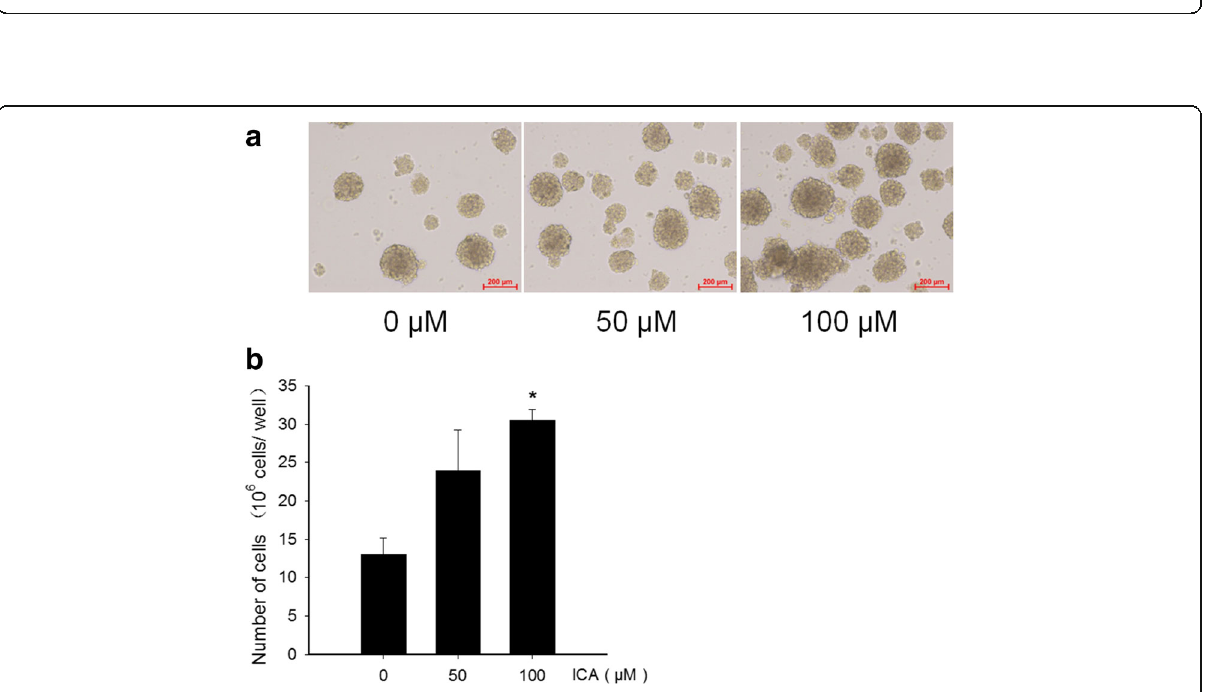
Fig. 2 Immunofluorescent staining of NSCs derived from rat hippocampus. a Nestin immunoreactivity (red) was positive. b EdU immunoreactivity (green) was positive compared to control. c The immunofluorescence staining showed positive NSE (green) and GFAP (red) expression. DAPI (blue) was used to stain the nuclei